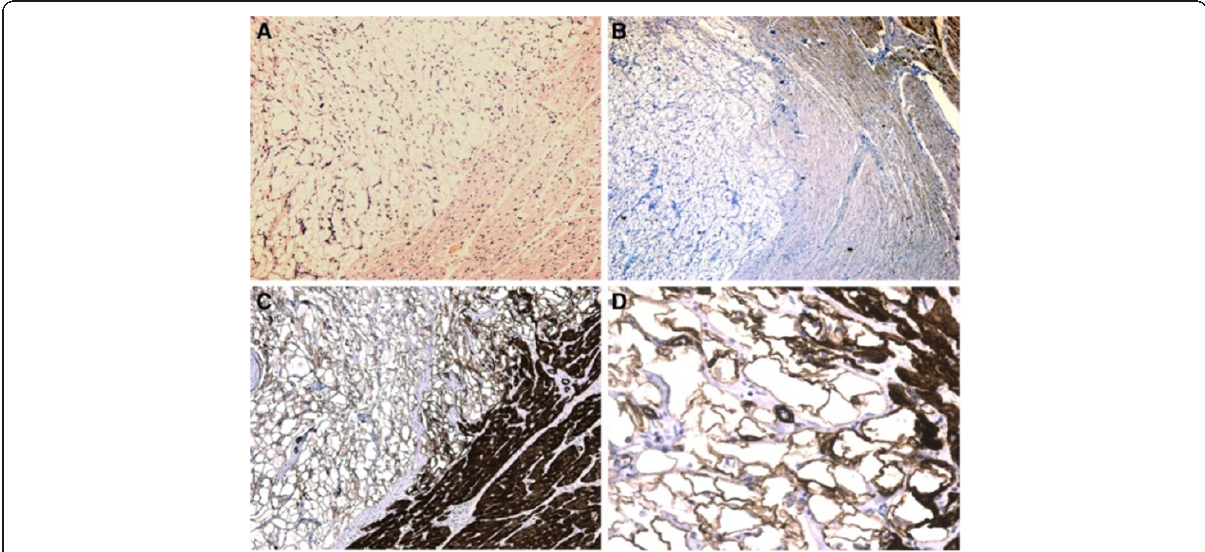
Figure 2 Microscopic findings. ( A ) Demarcation and separation of the tumoral mass from the surrounding regular parenchyma. Small residues of muscular tissue entrapped in the masses were also visible. Intense positive reaction for antibodies anti-Desmin ( B ), anti-Actin ( C - D